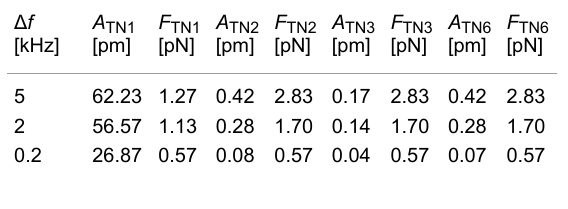
Table 2: Amplitudes A TN n resulting from thermal noise for n = 1, 2, 3 and 6 and respective drive forces F TN n for detection bandwidths Δ f of 5, 2 and 0.2 kHz.